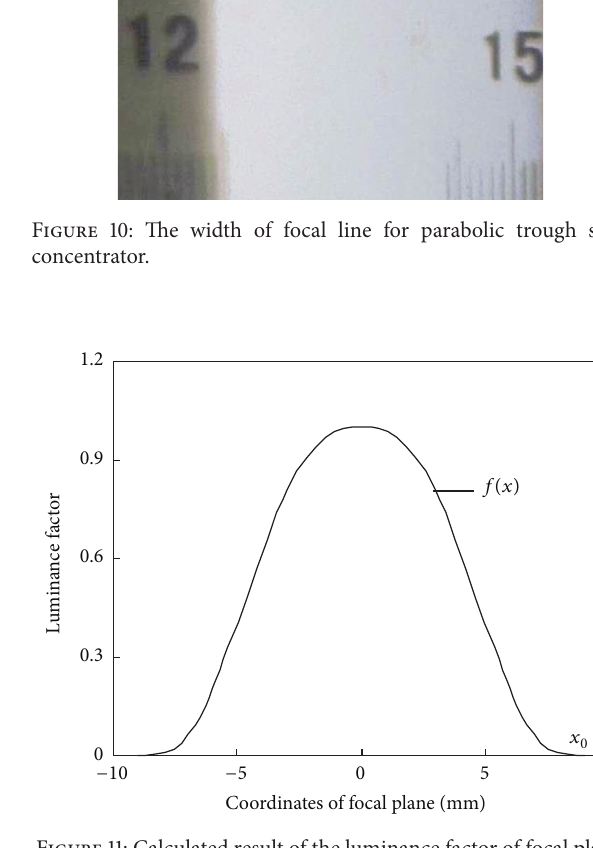
Figure 11: Calculated result of the luminance factor of focal plane.